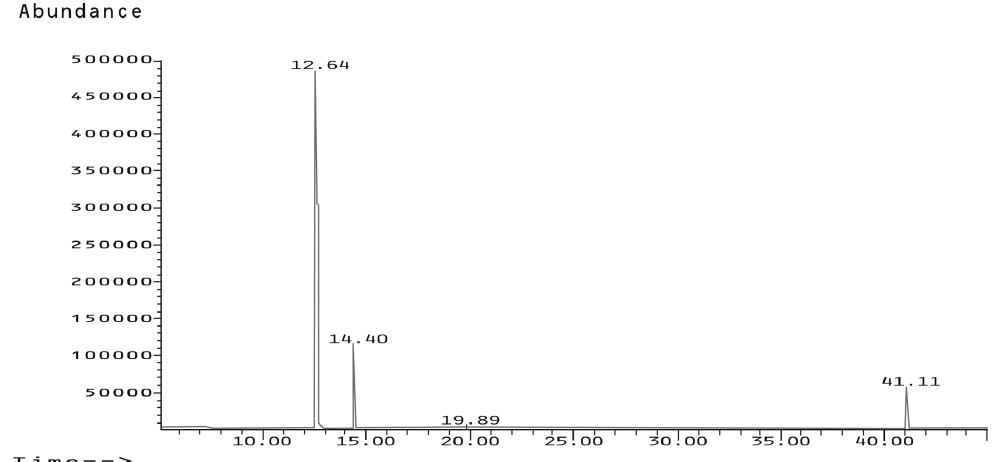
Fig. 2 – Chromatogram of the crude chloroform extracts from roots of Plumbago scandens after